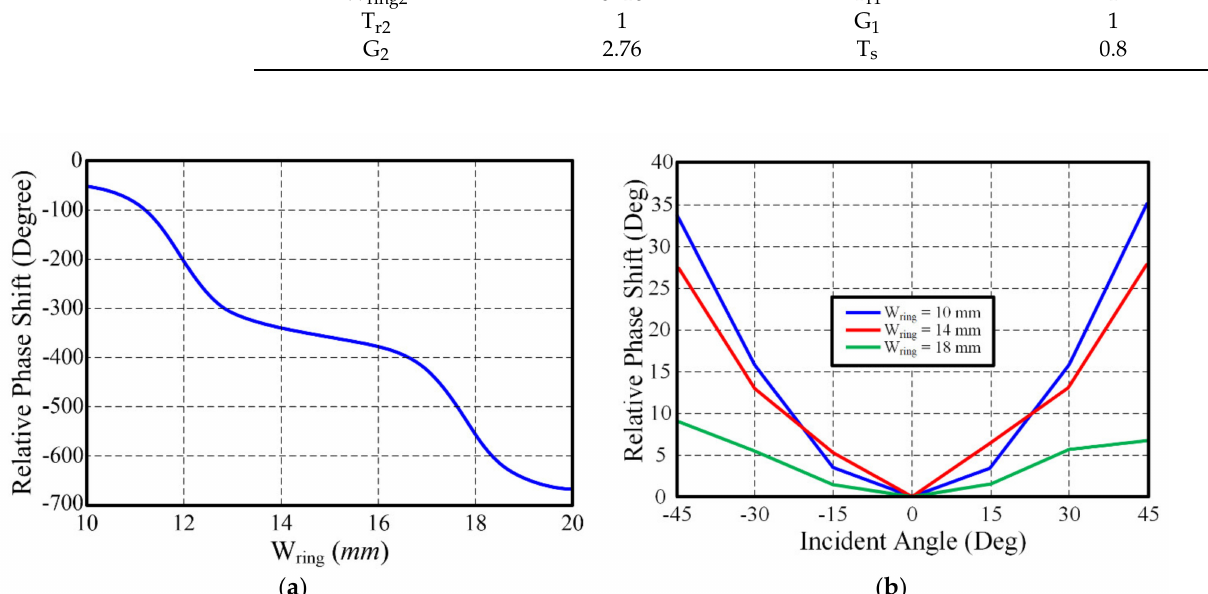
Figure 3. The relative phase shift of the reflected wave depending on ( a ) the size of the dual-square ring and ( b ) incident